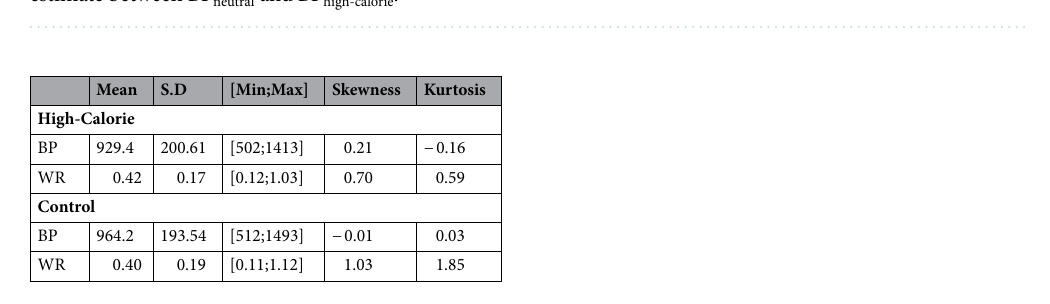
Figure 7. Graphical representation of the linear regression of the effect of diet control on the difference in time estimate between BP neutral and BP high-calorie .